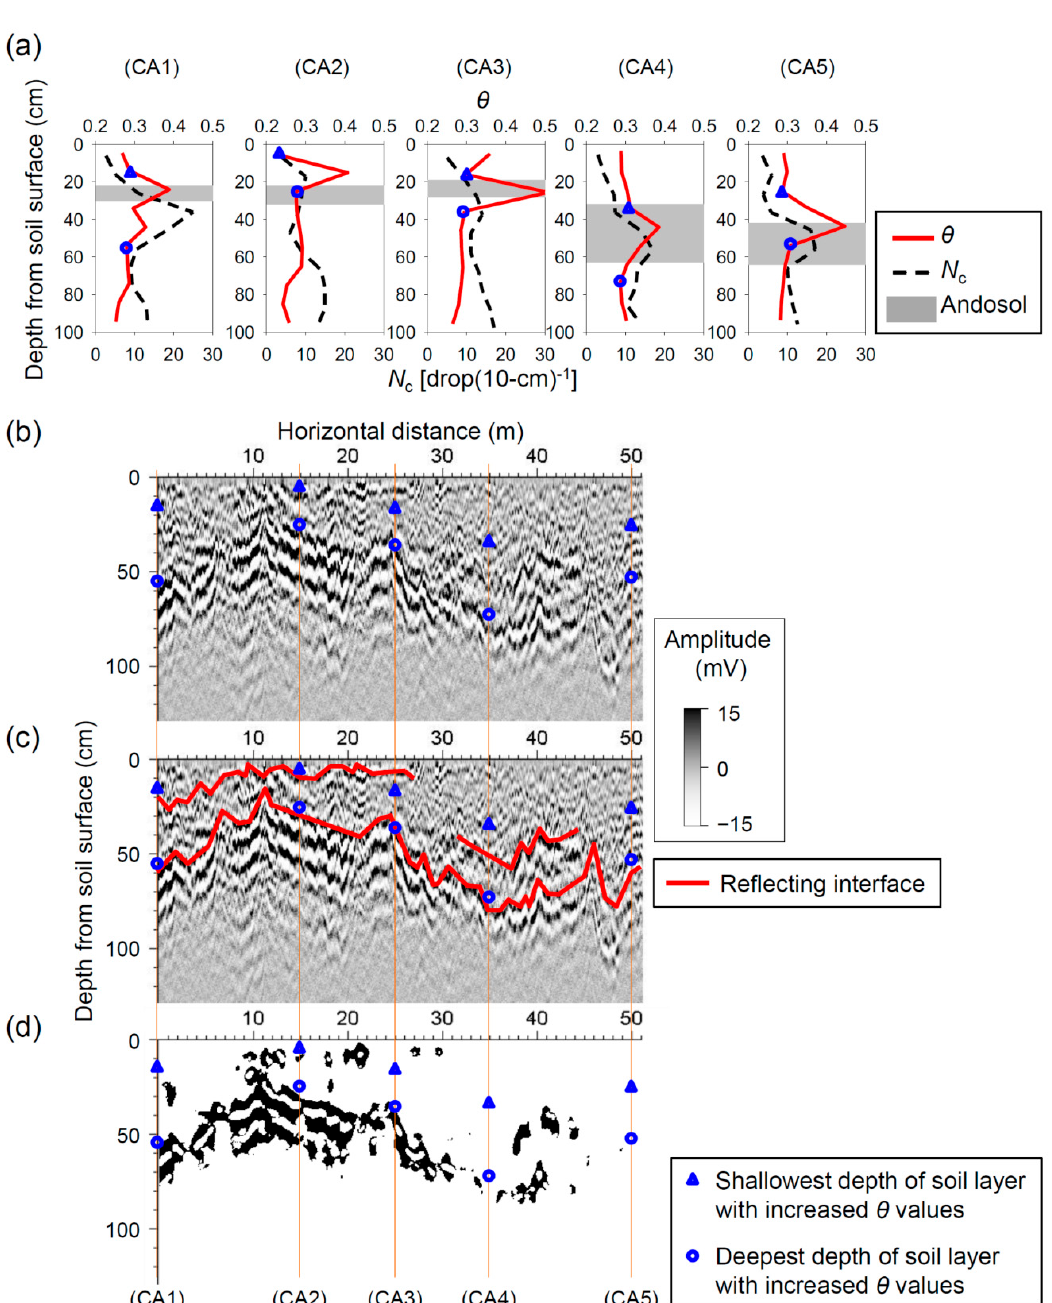
Figure 5. ( a ) Vertical profiles of θ and N C measured by the CPMP, ( b ) radargram, ( c ) radargram with interpretation of the reflecting interface, and ( d ) the area in which the median amplitude within a radius of five pixels was > 15 mV in the radargram at the CA